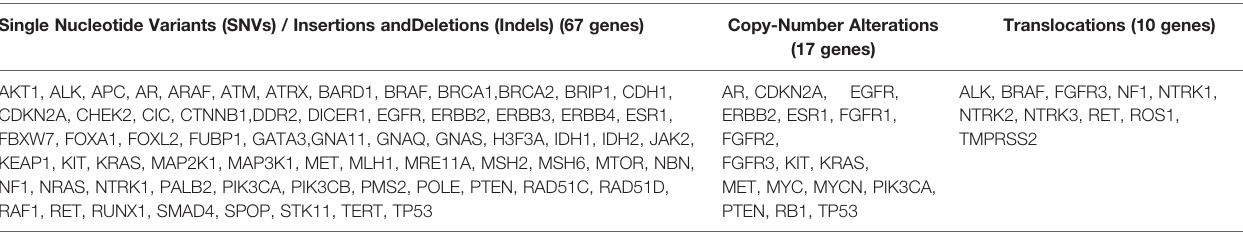
TABLE 1 | Custom 77-gene panel for targeted next-generation sequencing